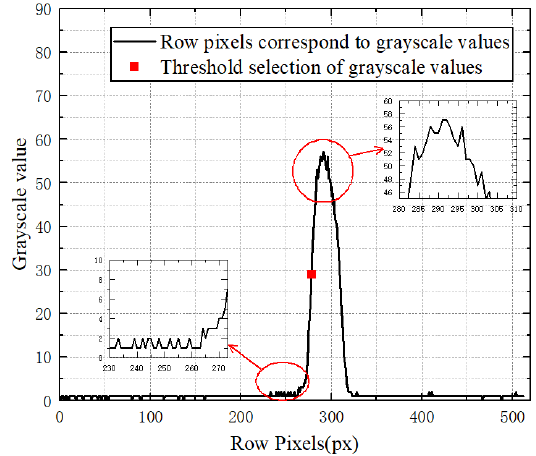
Figure 7. Yarn image row pixel greyscale values.